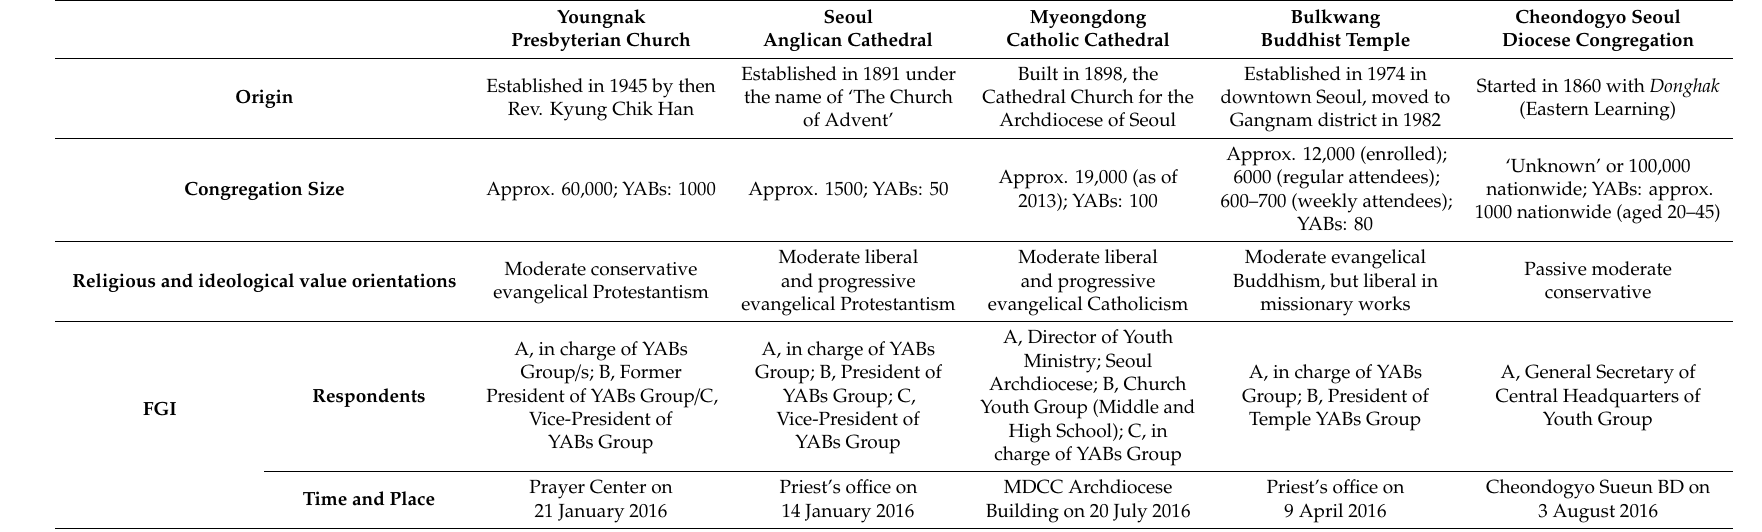
Table 1. Overview of Focus Group Interviews (FGIs) on Five Congregations. (YABs = young adult